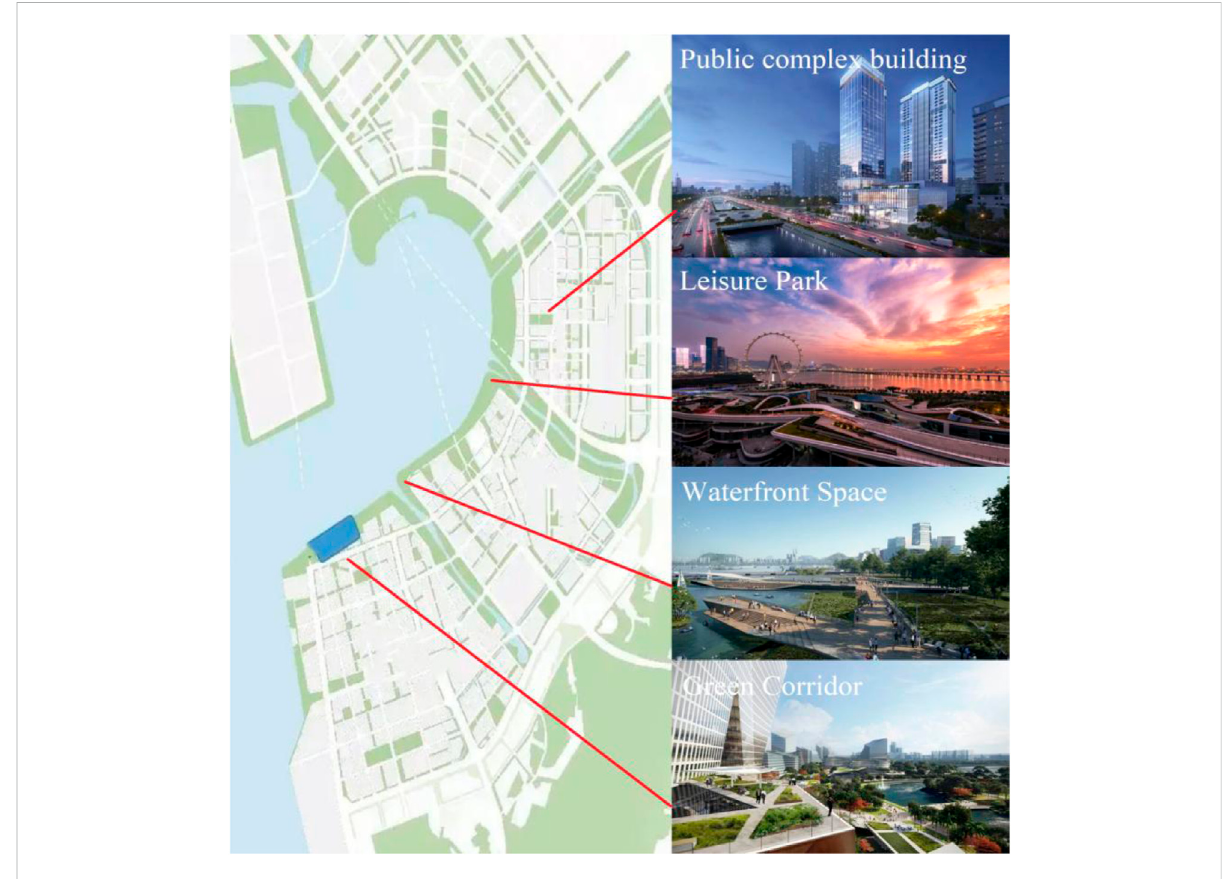
FIGURE 3 The forms of public space in the Qianhai cooperation